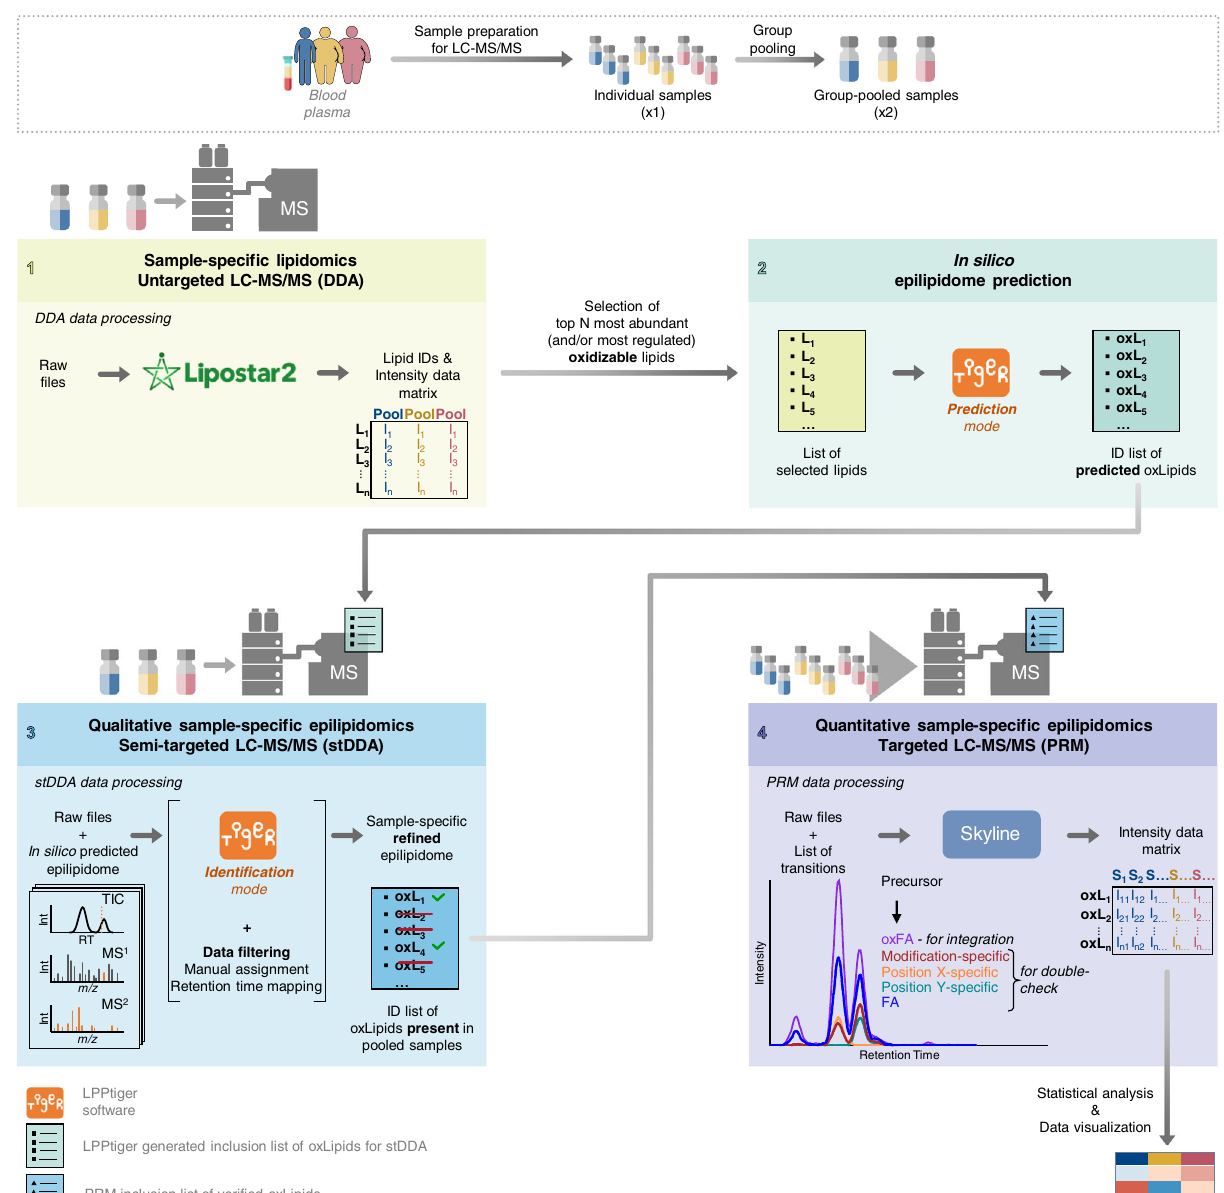
Fig. 4 | Schematic representation of analytical and bioinformatics work fl ow developed for identi fi cation and relative quanti fi cation of oxidized complex lipids. Blood plasma lipids are extracted and experimental group-speci fi c pooled samples are prepared by mixing equal amounts of each individual sample within the group. Step 1: Group-speci fi c pooled samples are used for untargeted LC-MS/ MS analysis (e.g. using data-dependent acquisition, DDA) to identify native, non- oxidized lipidome of biological system in question (here, human blood plasma). Data processing for identi fi cation of native lipidome can be done by any suitable software of user choice (e.g. Lipostar 2). Step 2: Most abundant and/or most regulated lipids containing polyunsaturated acyl chains (and thus susceptible